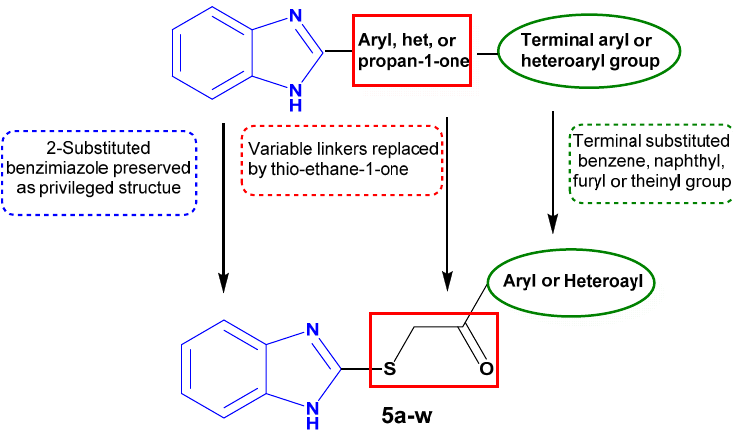
Figure 2. Structure-based design of target benzimidazoles 5a – w as anti-triple-negative breast cancer (TNBC) agents.